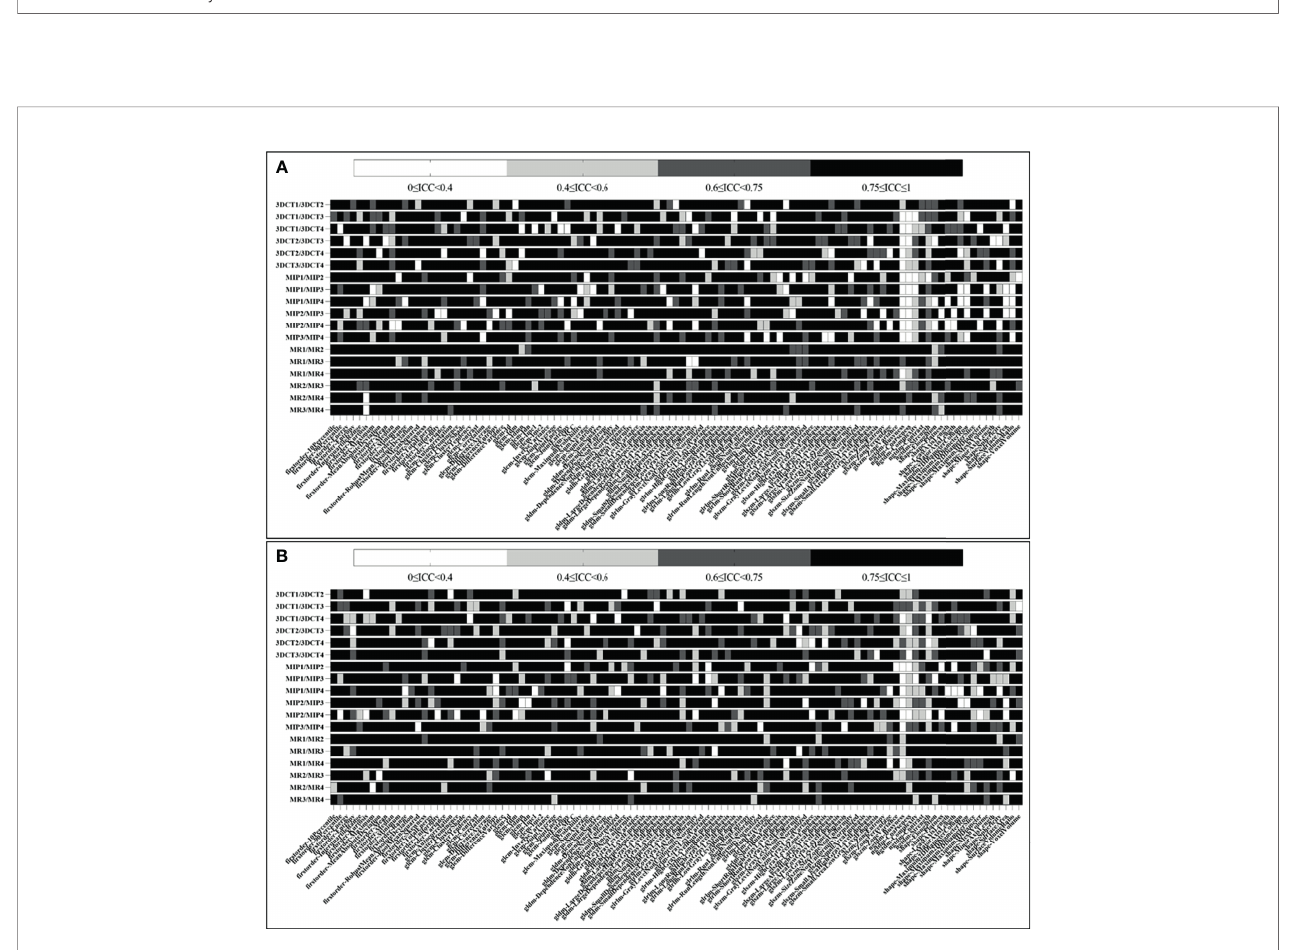
FIGURE 3 | Heatmap demonstrating tumor and peritumor tissue-derived reproducible features, where each row and column represent each comparison dataset and radiomic feature, respectively. (A, B) show the ICC results of tumor and peritumor tissues, respectively.